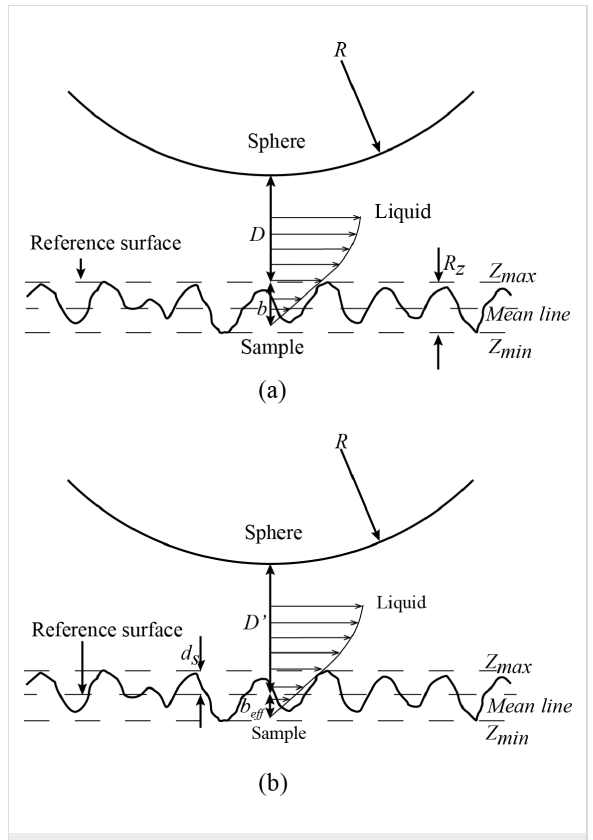
Figure 4: Schematic illustrating possible definitions of the boundary- slip condition at a rough surface. (a) The boundary-slip condition with the reference surface set at the peak of the sample. (b) The boundary- slip condition with the position of the reference surface set between the peaks and valleys of the sample, where b eff is the effective slip